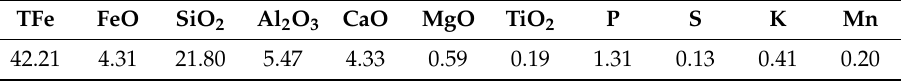
Table 3. Chemical composition of high phosphorus oolitic iron ore (mass fraction, wt%).